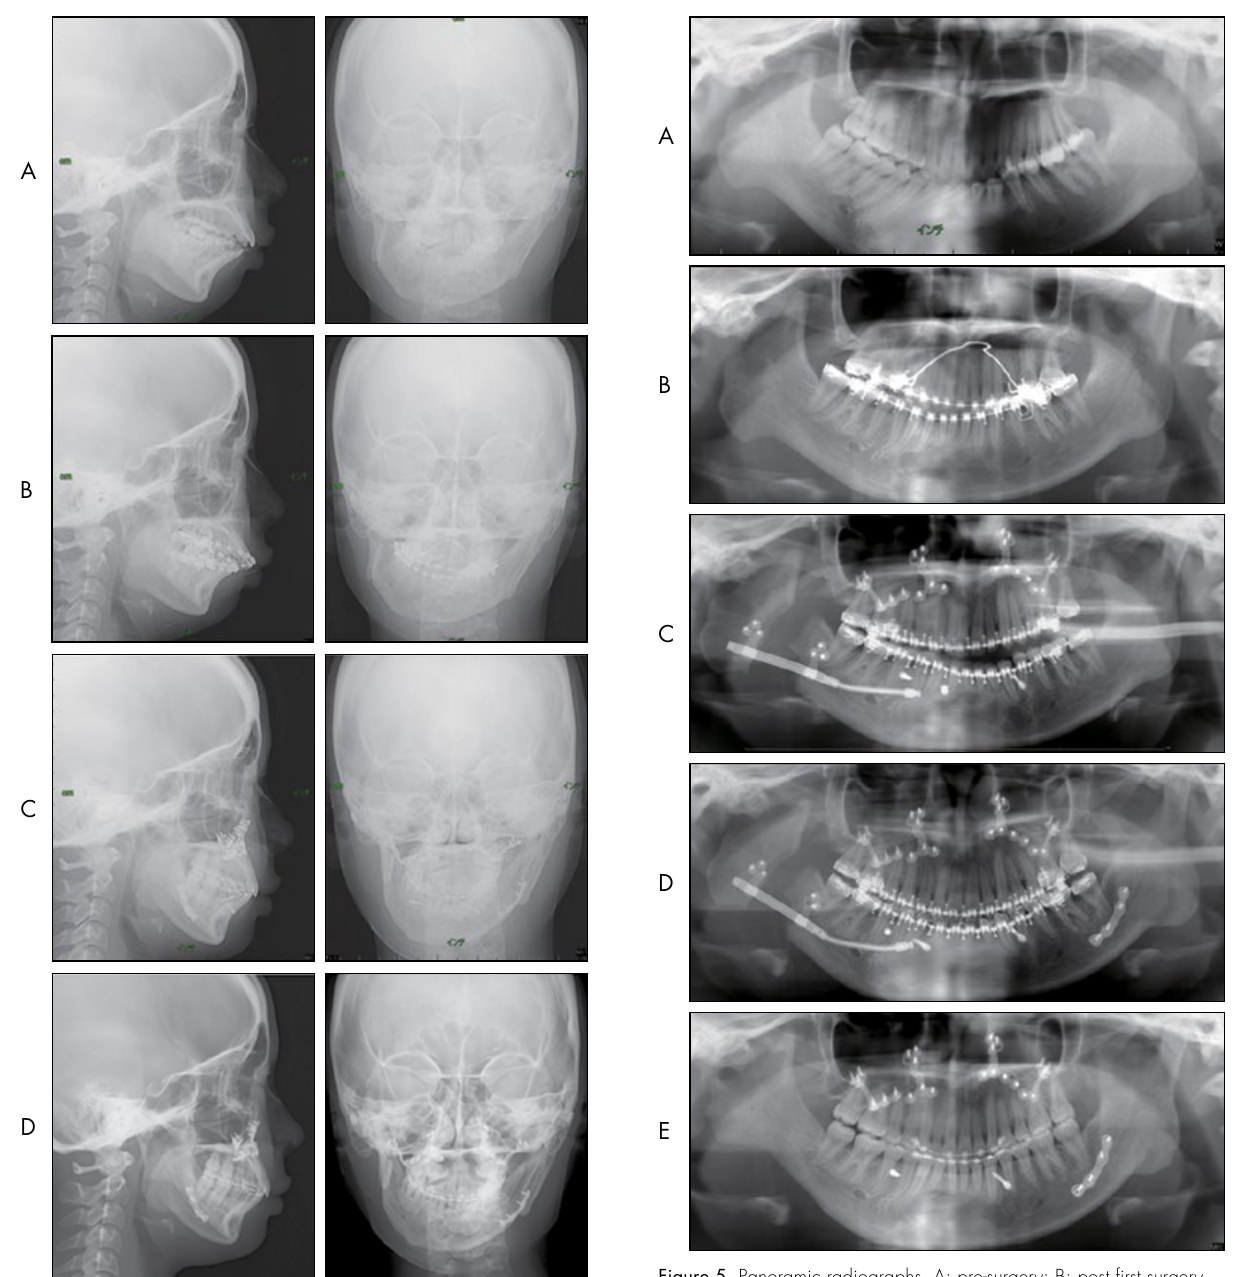
Figure 5. Panoramic radiographs. A: pre-surgery; B: post first surgery (LF1 and DO surgery), just before the second surgery (left USSO); C: post second surgery, reactivation of the right distraction device was completed; D: post-treatment, one year after